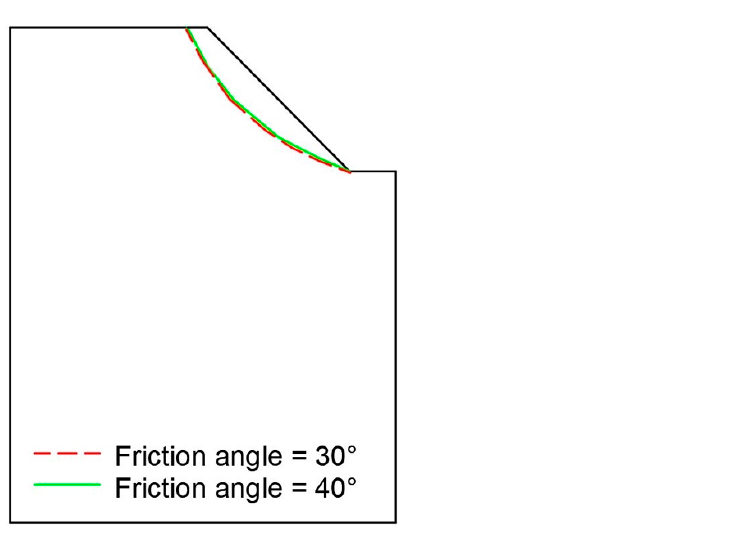
Figure 4. Effect of friction angel on static failure surface for cohesion value of 6 kPa.